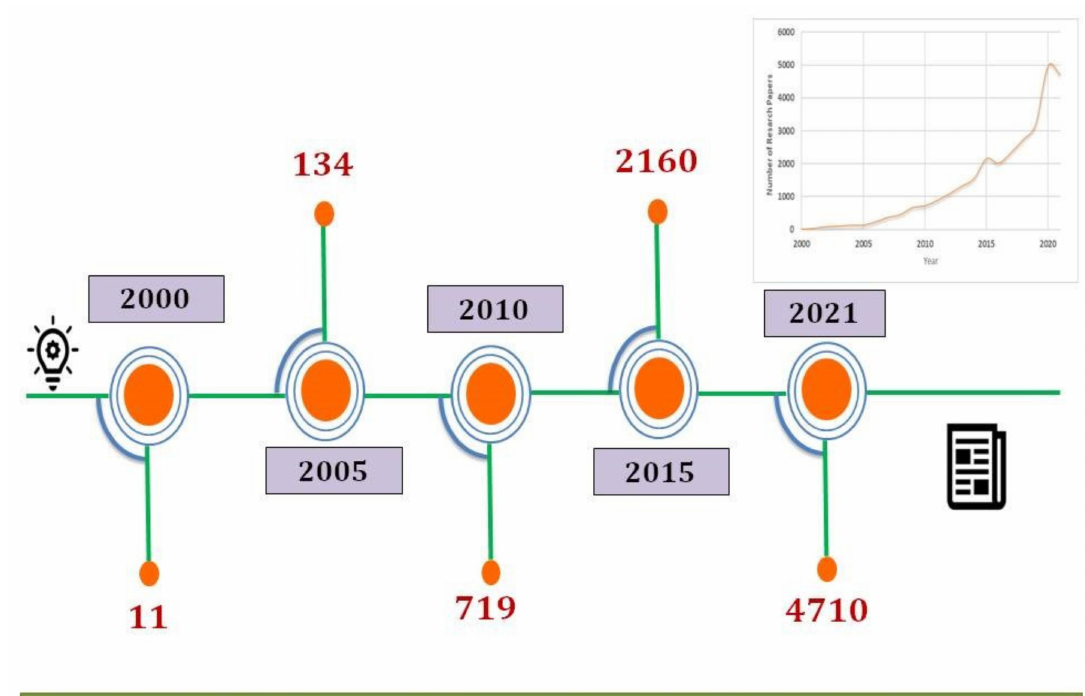
Figure 1. Escalating research on biofortification in the last two